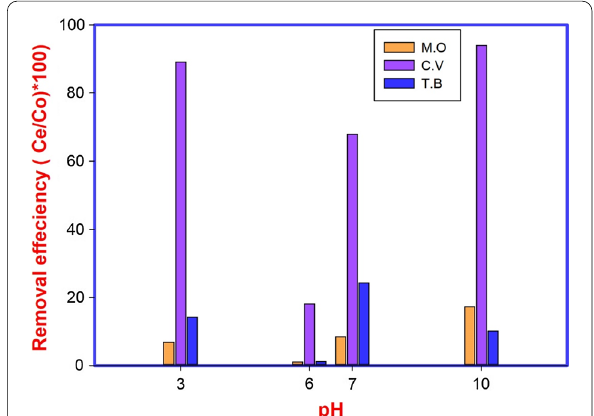
Fig. 7 Effect of contact time on the removal efficiency of C.V over sodium titanate nanotubes